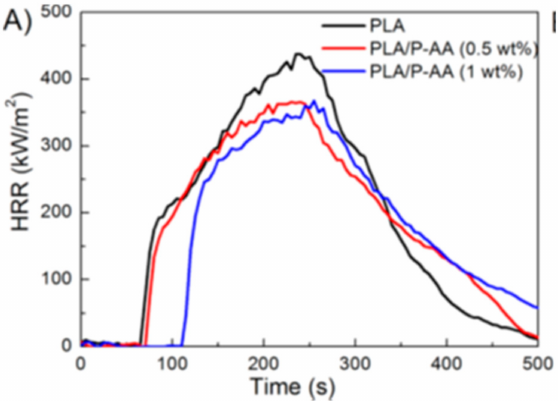
Figure 1. HRR vs. time curves of PLA and PLA/P-AA. (Adapted with permission from